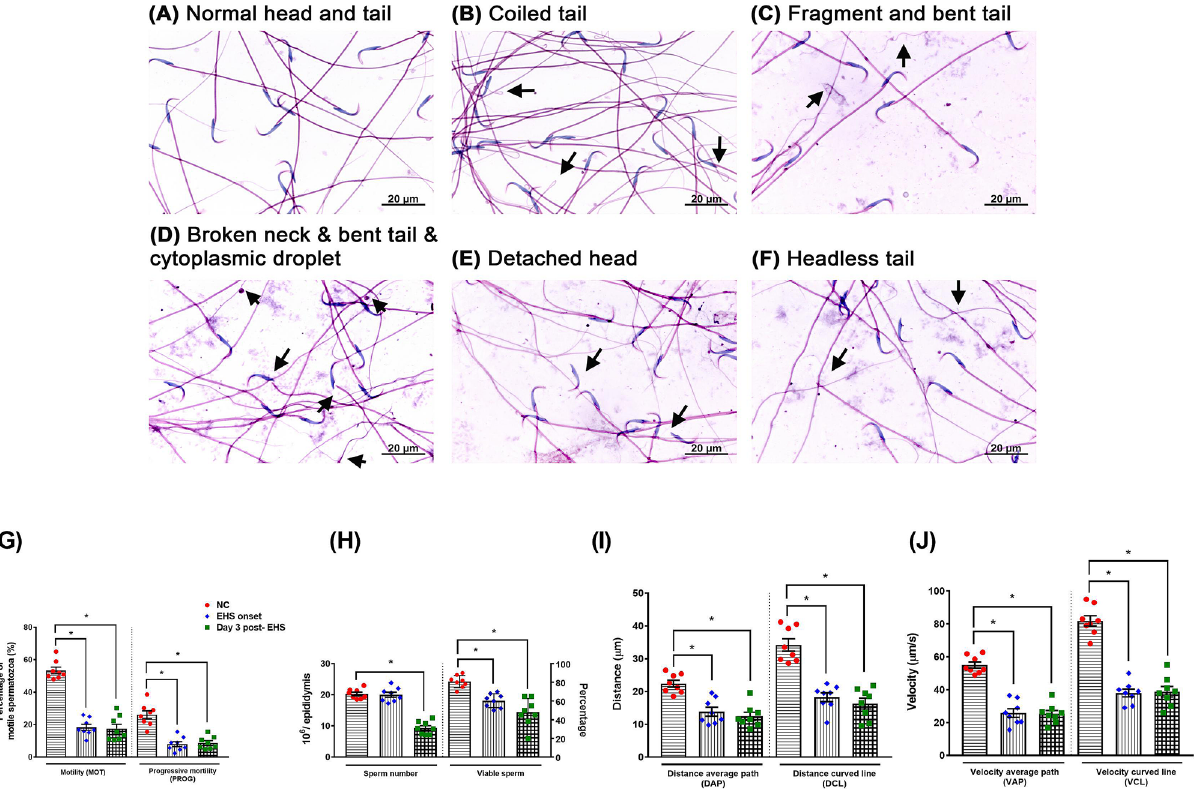
Figure 7. Microphotographs were illustrating morphologically normal sperm and various sperm defects. ( A ) Normal head and tail from a NC rat. ( B ) Coiled and ( C ) fragment and bent tail from an EHS onset rat. ( D ) Broken neck, bent tail, cytoplasmic droplet, ( E ) detached head, and ( F ) headless tail from a Day 3 post-EHS rat. ( G ) The percentage of sperm motility (MOT) and the percentage of sperm with progressive motility (PROG), ( H ) sperm numbers and viable sperm percentages, ( I ) the distance average path (DAP) and distance curved line (DCL), and ( J ) the velocity average path (VAP) and velocity curved line (VCL) were elevated (p < 0.05) in